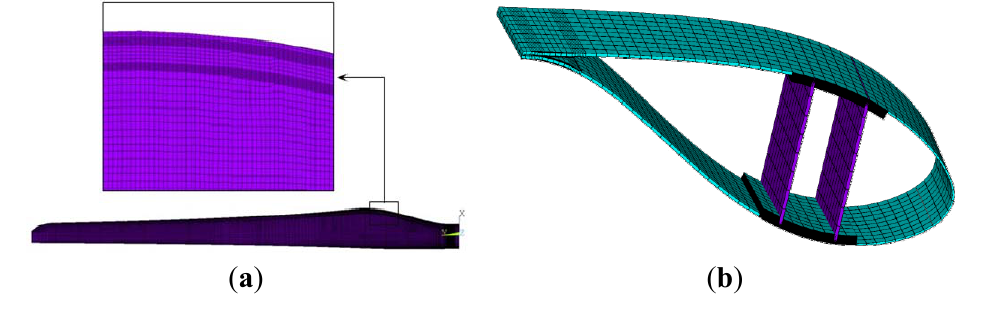
Figure 7. ( a ) Finite element of rotor blade; and ( b ) Blade station of contact